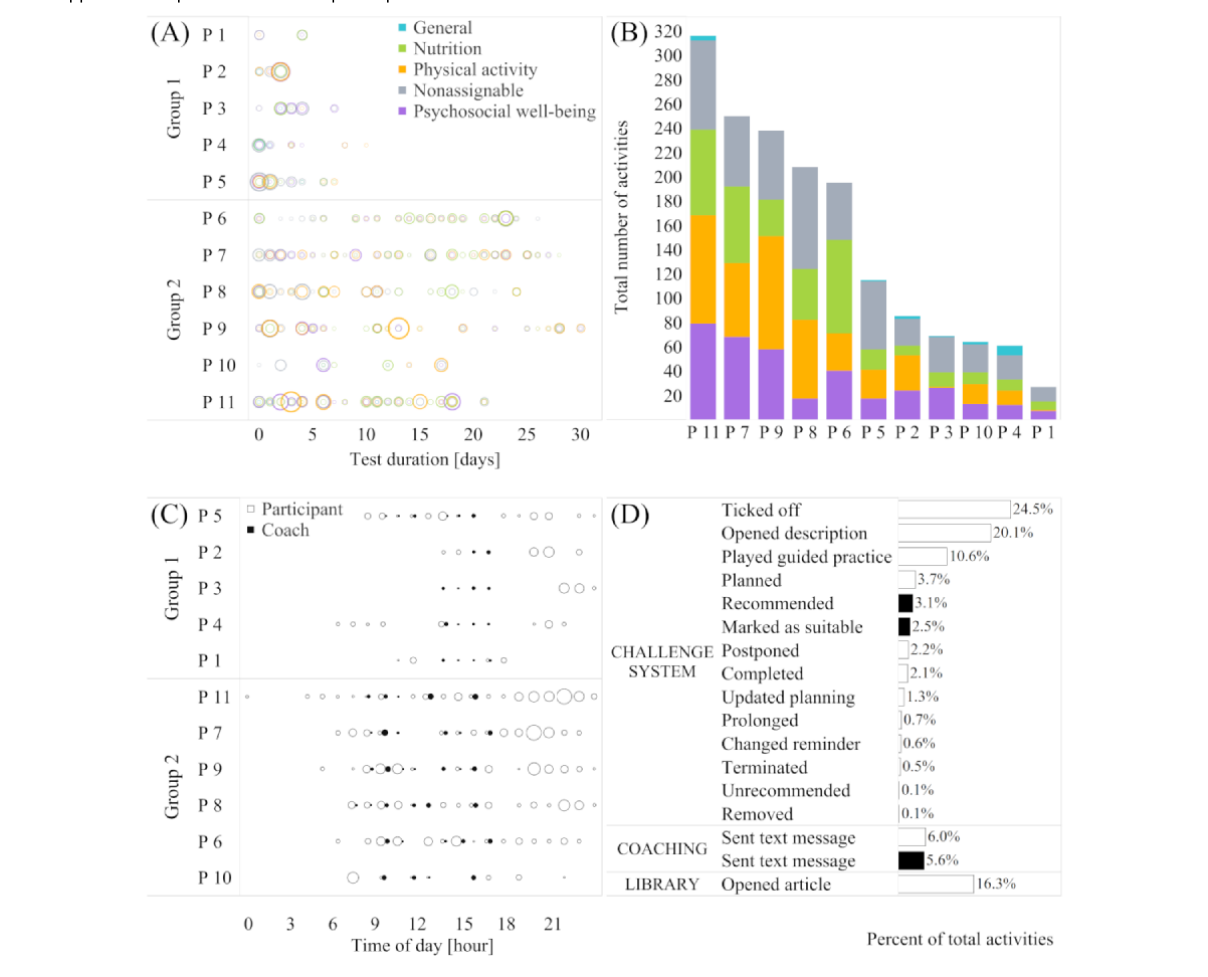
Figure 4. App usage in the TRIANGLE user study (n=11; group 1: n=5; group 2: n=6). (A) Number of app activities per participant over time stratified by theme; 1 circle per active day, with circle size reflecting the number of activities. (B) Total number of app activities per participant stratified by theme. (C) Number of app activities per participant and time of day; 1 circle per active hour, with circle size reflecting the number of activities. (D) Percent of app activities per subfeature. P: